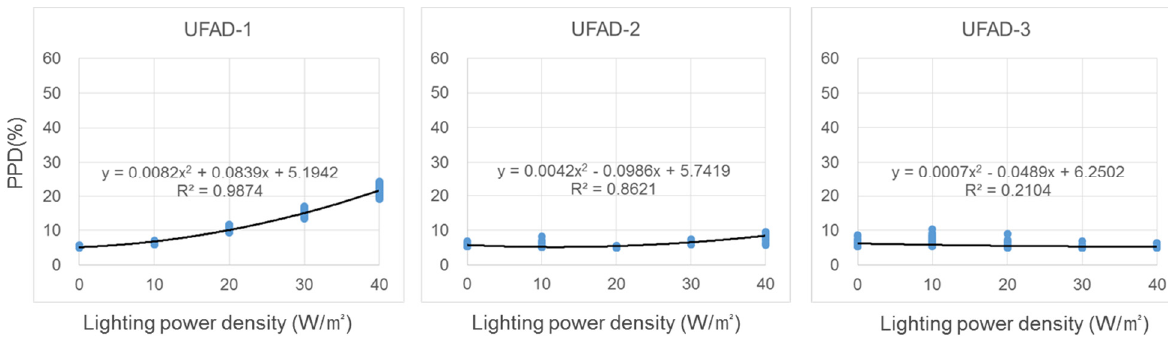
Figure 29. Correlation between lighting power density and PPD for